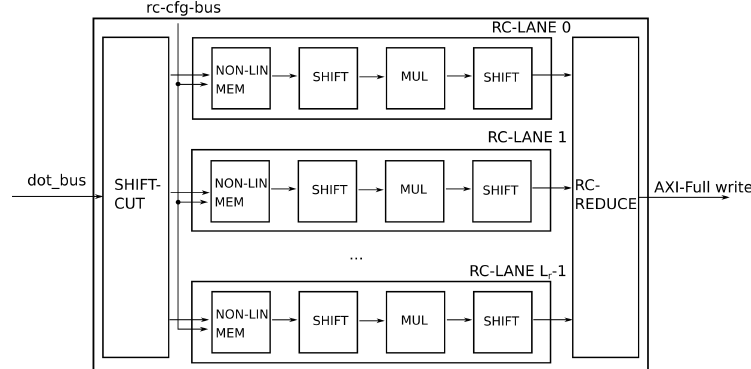
Figure 6. The RECONF architecture.